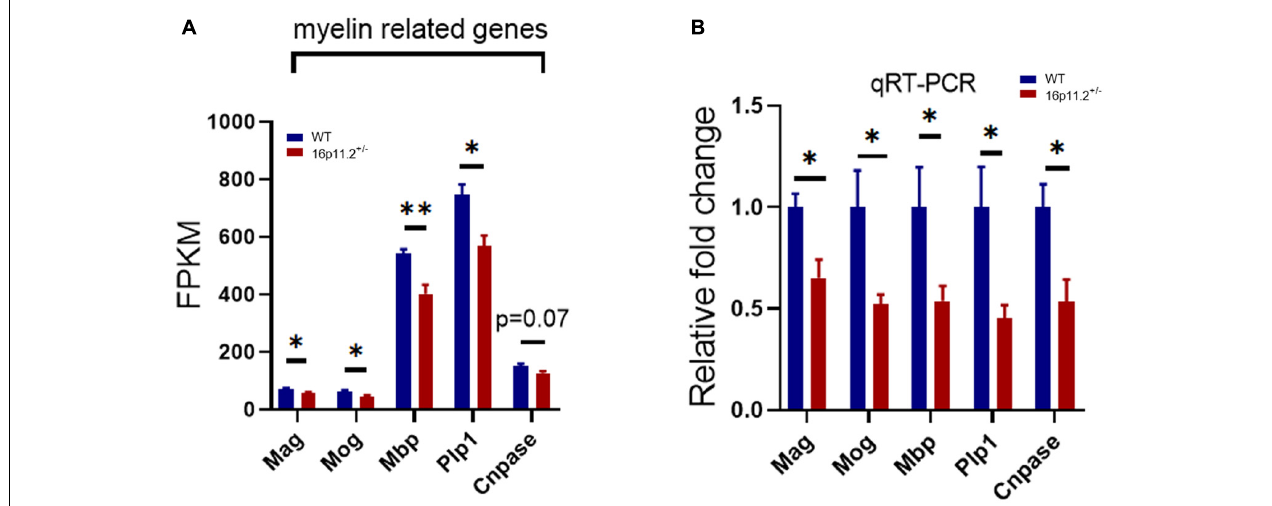
FIGURE 1 | Decreased expression of myelin-related genes in 16p11.2 ± striatum. (A) Decreased expression levels (in FPKM) of myelin-related genes in 16p11.2 ± striatum. Total RNA was extracted from striatum tissues of 16p11.2 ± mice ( n = 4) and WT controls ( n = 4) at P60 for RNAseq analysis. (B) Downregulated mRNA expression (relative to Gapdh ) of Mag , Mog , Mbp , Plp1 and Cnpase in 16p11.2 ± striatum as assessed by qRT-PCR ( n = 4–6 mice). Data were analyzed with unpaired t tests (mean ± SEM, * p < 0.05, ** p < 0.01). Mag , Myelin associated glycoprotein ; Mog , Myelin oligodendrocyte glycoprotein ; Mbp , Myelin basic protein ; Plp1 , Proteolipid protein 1 ; Cnpase , Cyclic nucleotide phosphodiesterase . FPKM, Fragments per kilobase of transcript per million mapped reads.